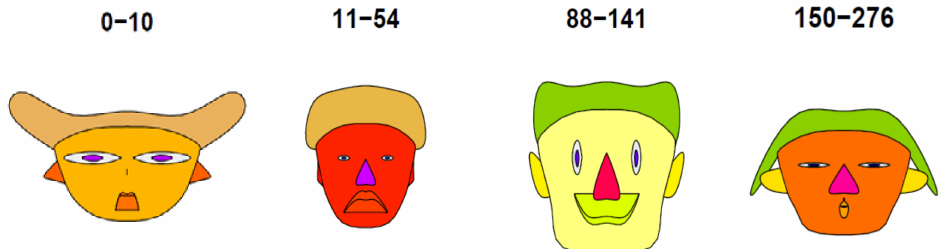
Figure A1. The Chernoff faces diagram, which reflects the parameters and some key processes in the soil of wildfire-affected larch stands of different age (0–14, 15–54, 78–100, 119–276-year-old stands) and describes them as characteristics of the human face: face height—vegetation cover height (VegH), face width—litter thickness (LitD), face shape—root biomass (roots), mouth height —mean soil respiration (SR), mouth width—mean soil basal respiration (BR), smile curve—mean soil substrate-induced respiration (SIR), eye height—mean summer soil water content at the depth of 5 cm (SWC5), eye width— mean summer soil temperature (ST5), hair height—mean September ST5, hair width—mean August ST5, hair styling—mean July ST5, nose height—mean C content, nose width—mean N content, ear width—C/N, ear height—VegHLitD (VegH and